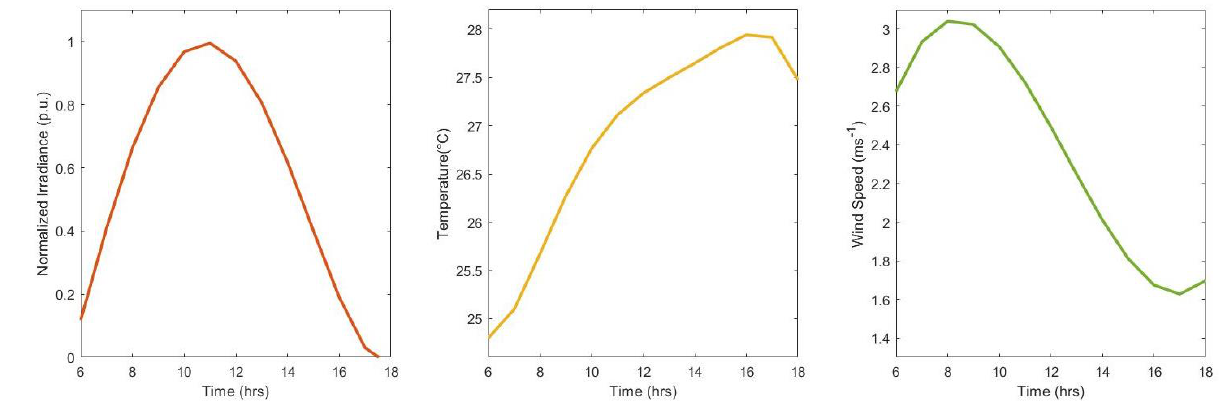
Figure 6. Variation of irradiance, temperature and wind speed during the simulation period.